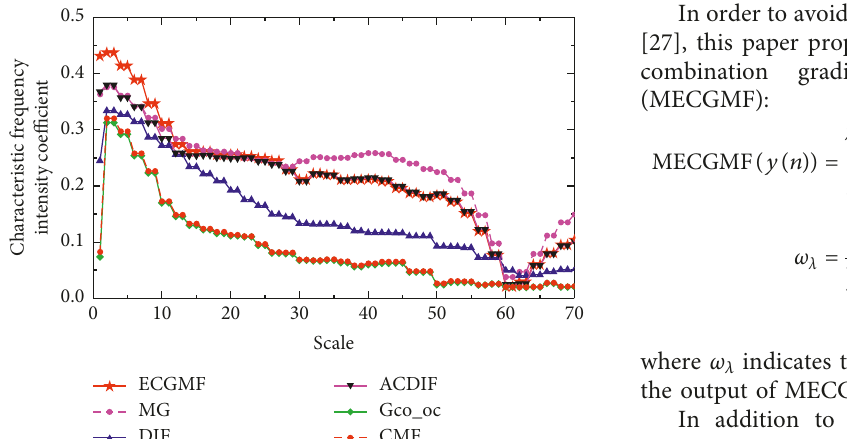
( t ) , (c) Gaussian white noise δ ( t ) , and (d) simulation signal y ( t ) . 1